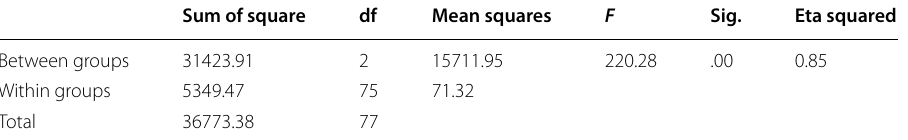
Table 13 Findings of one-way ANOVA: the participants’ post-tests of FLLM Sum of square df Mean squares Sig. Between groups